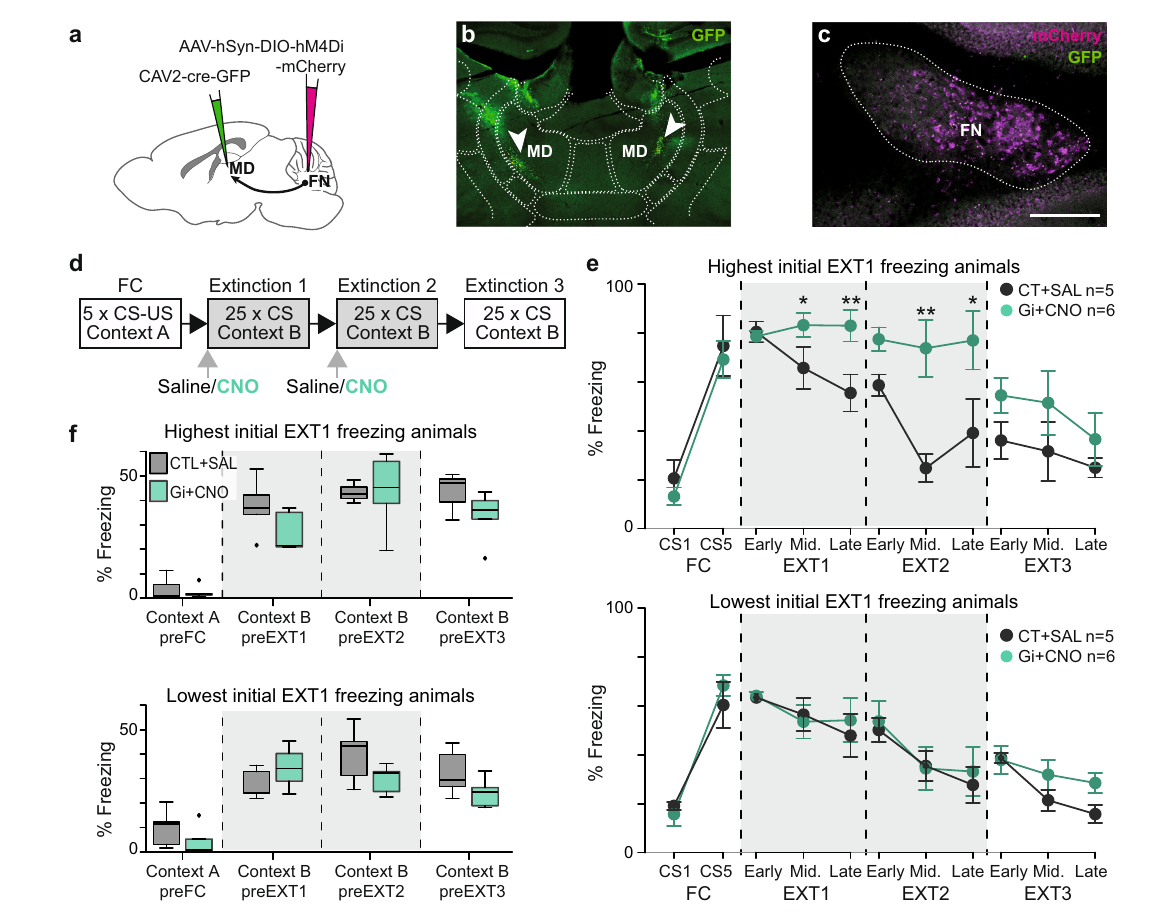
Fig. 4 | FN input to MD modulates fear extinction. a Chemogenetic strategy to inhibit speci fi cally the activity of FN-MD input, bilateral retrograde expression of cre recombinase in MD by CAV2-cre-GFP infusion and anterograde cre-dependent expression ofinhibitoryDREADD (hM4Di (Gi))inthe cerebellarFN. b Injection site of CAV2-cre-GFP in the MD. c Cre-dependent expression of inhibitory DREADD reported by mCherry fl uorescence in the FN (scale bar, 250 µ m). d Classical fear conditioning and extinction protocol used. FN-MD projections were inhibited by CNO administration during extinction 1 and 2. e FN-MD input inhibition (Gi+CNO, n =12) during extinction sessions 1 and 2 reduced extinction of fear response compared to the control group (CT+SAL, n =10). The mice were separated in two